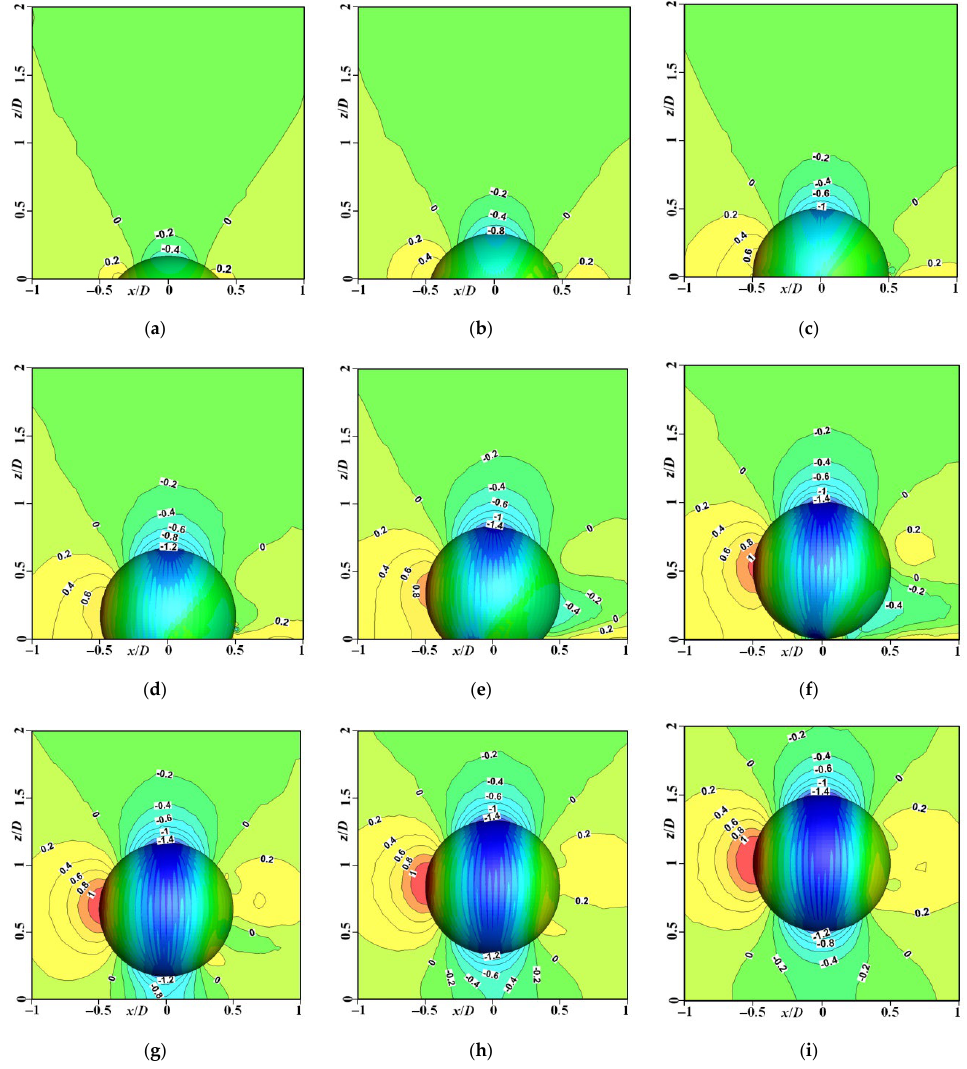
Figure 6. Mean pressure coefficient on the surface of sphere and in the centre plane of the domain (reference height: 10 m): ( a ) Model 2; ( b ) Model 4; ( c ) Model 6; ( d ) Model 8; ( e ) Model 10; ( f ) Model 12; ( g ) Model 14; ( h ) Model 16; ( i ) Model 18.